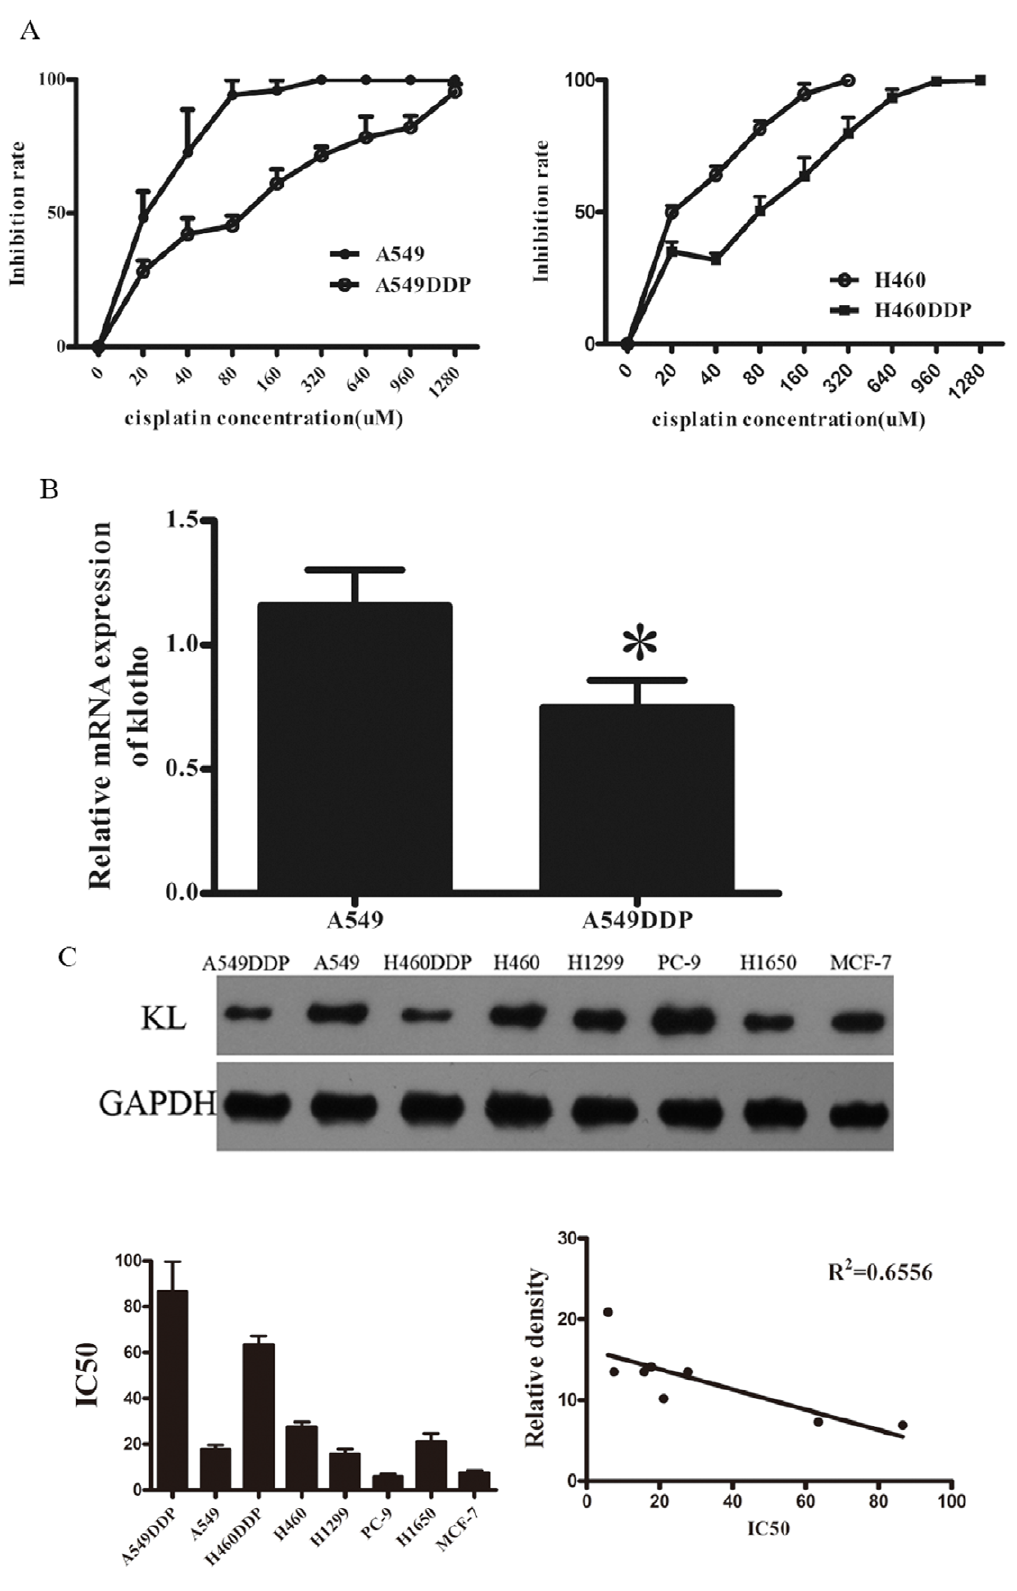
Figure 1. IC50 and klotho expression in cisplatin resistant cells and their parent cells. A : Two cell lines treated with cisplatin showed difference in IC50. B : Quantitative RT-PCR for the detection of klotho expression in A549 cells and A549DDP cells. C : Western blot analysis of klotho expression in a panel of lung cancer cell lines including two cisplatin resistant variants and a breast cancer cell line (MCF-7). Klotho expression is